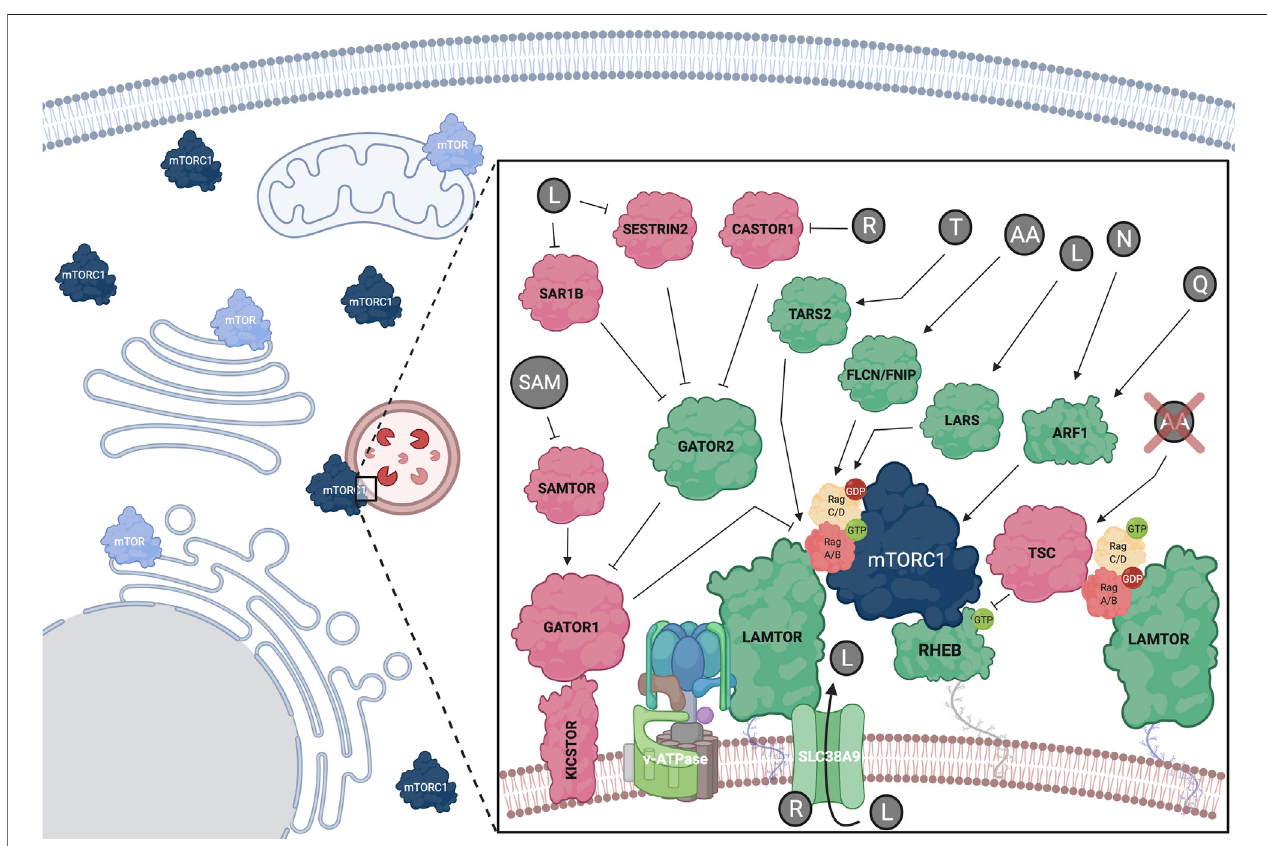
FIGURE 2 | Amino acids regulate mTORC1 at the lysosomal surface via a complex upstream regulatory protein network that impinges upon the Rag GTPase dimers. Positive mTORC1 regulators shown in green; negative regulators shown in red. Additional subcellular locations, where mTOR was previously found, are also depicted. See text for details. Created with